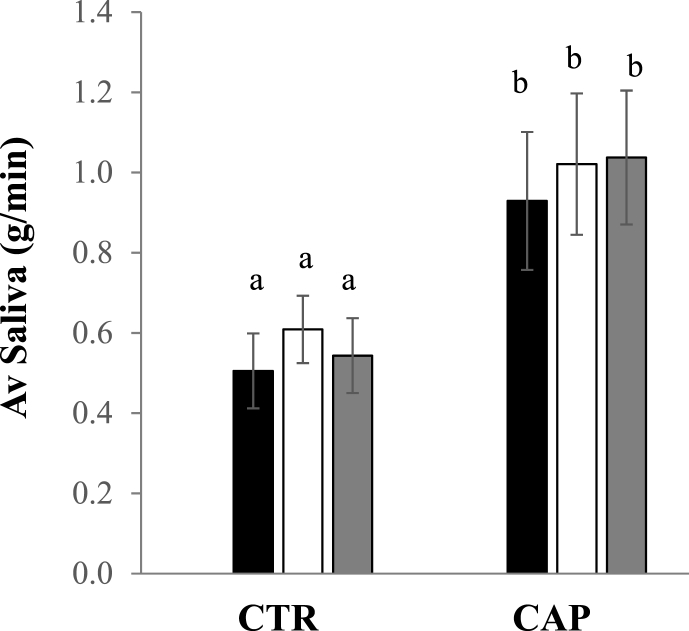
Impact of capsaicin on saliva secretionAverage saliva flow (g/min) measured from 15 participants for CTR and CAP on three consecutive days (rep 1,2, 3 shown in black, white, grey bars with standard errors), letter a and b indicated a statistical difference at p < 0.001.